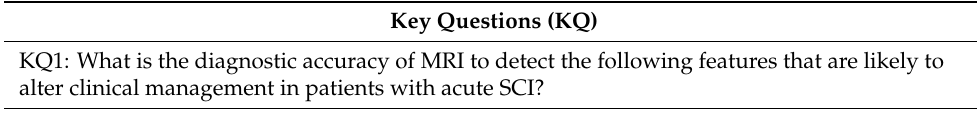
Table 1. Key Questions of Systematic